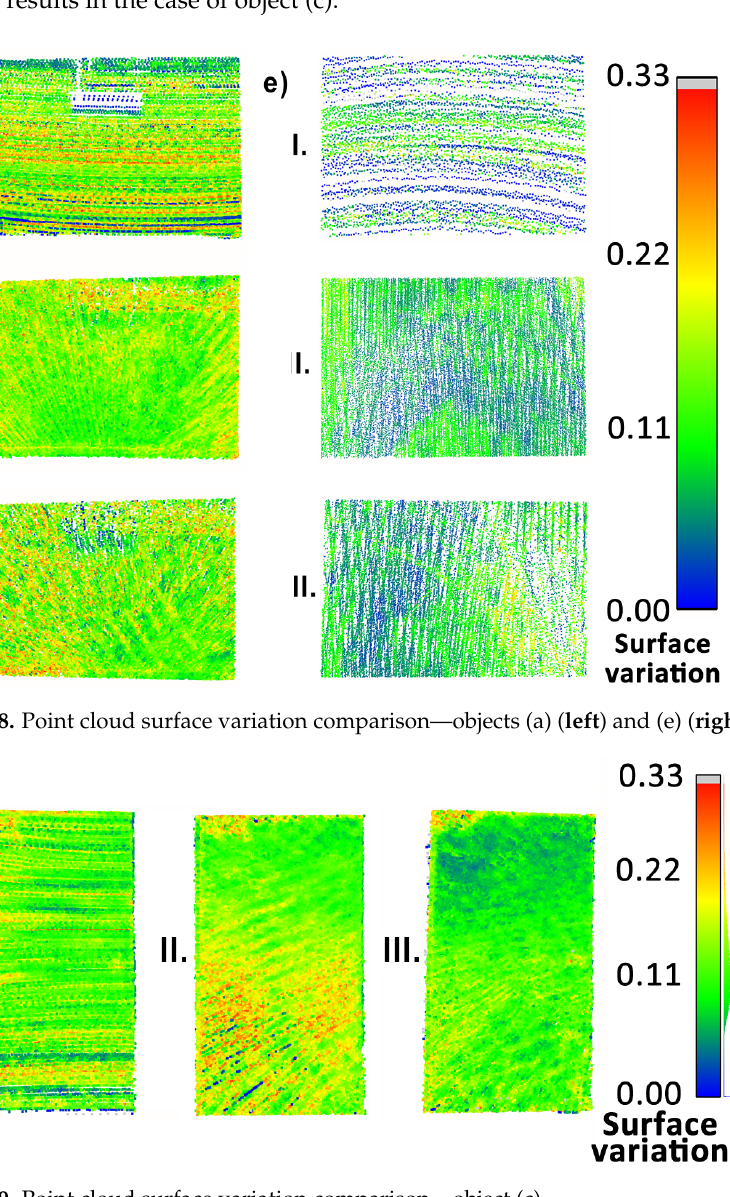
Figure 19. Point cloud surface variation comparison—object